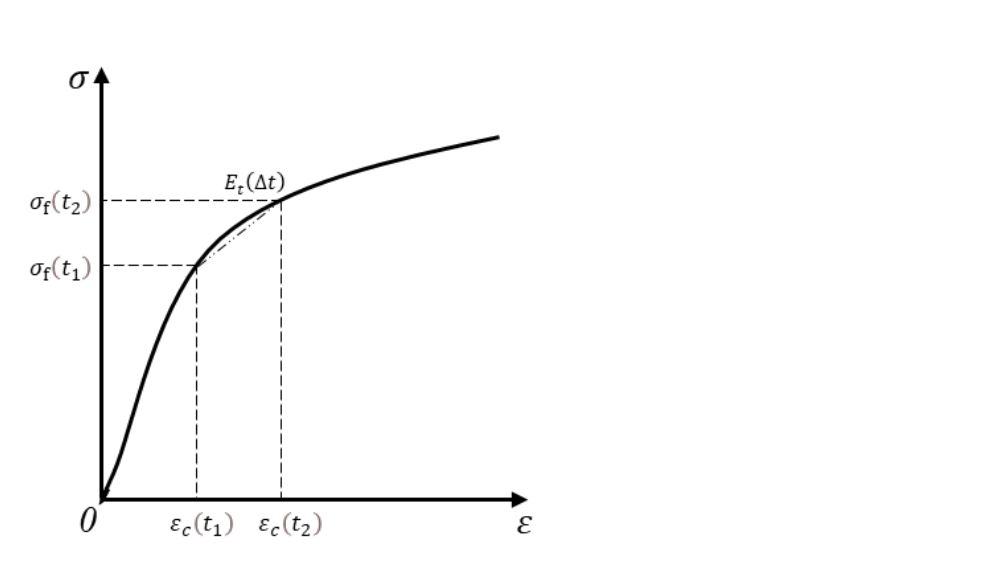
Figure 1. Schematic diagram of the elastic modulus of a micro-matrix around the capillary ( E t ).